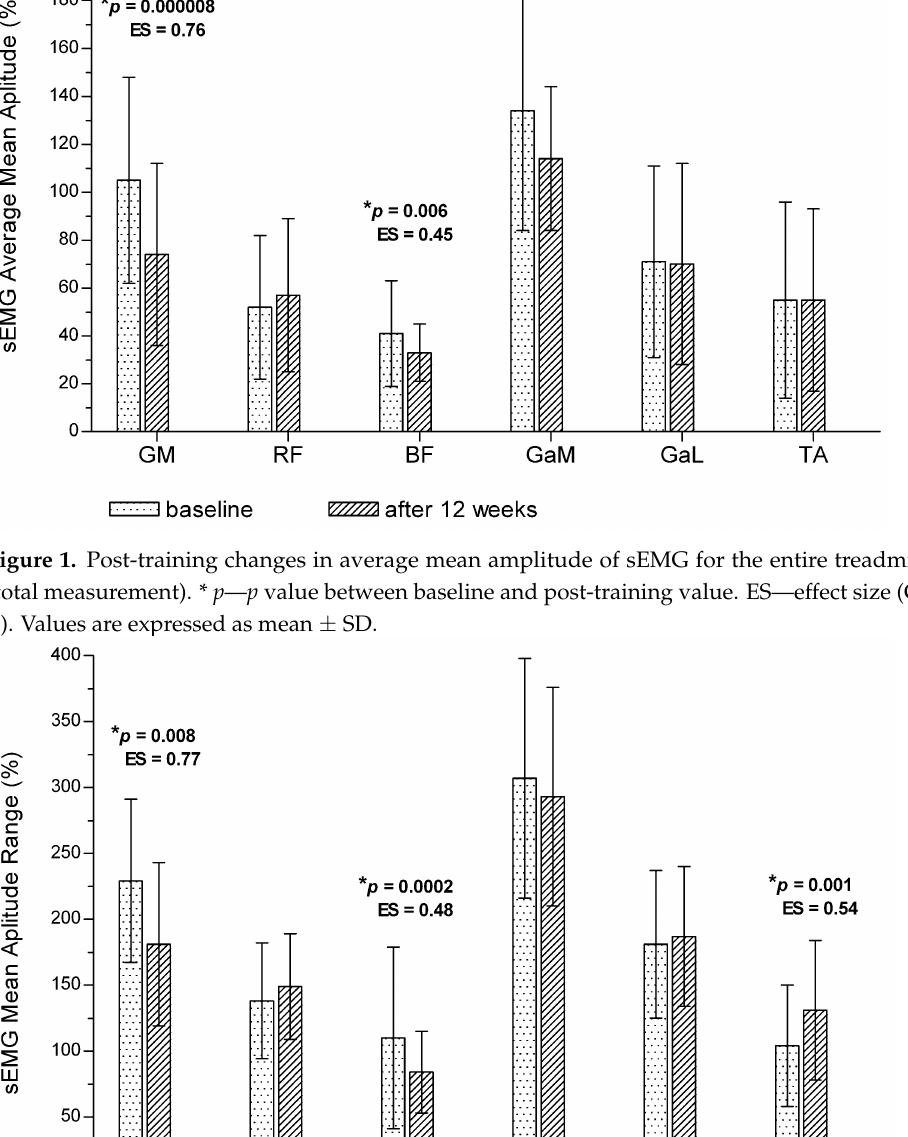
Table 1. Comparison of average mean amplitude of sEMG signal in pain-free and in painful inter- vals of the treadmill test.